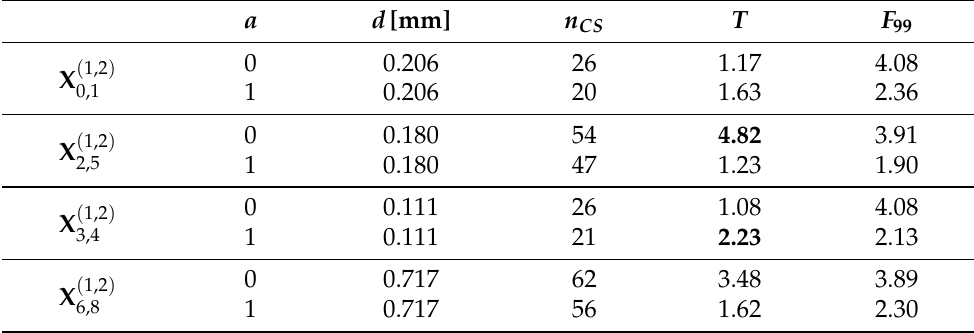
Table 4. Results of the localisation for selected point pairs (data set V0). Type I errors are printed in bold [30].